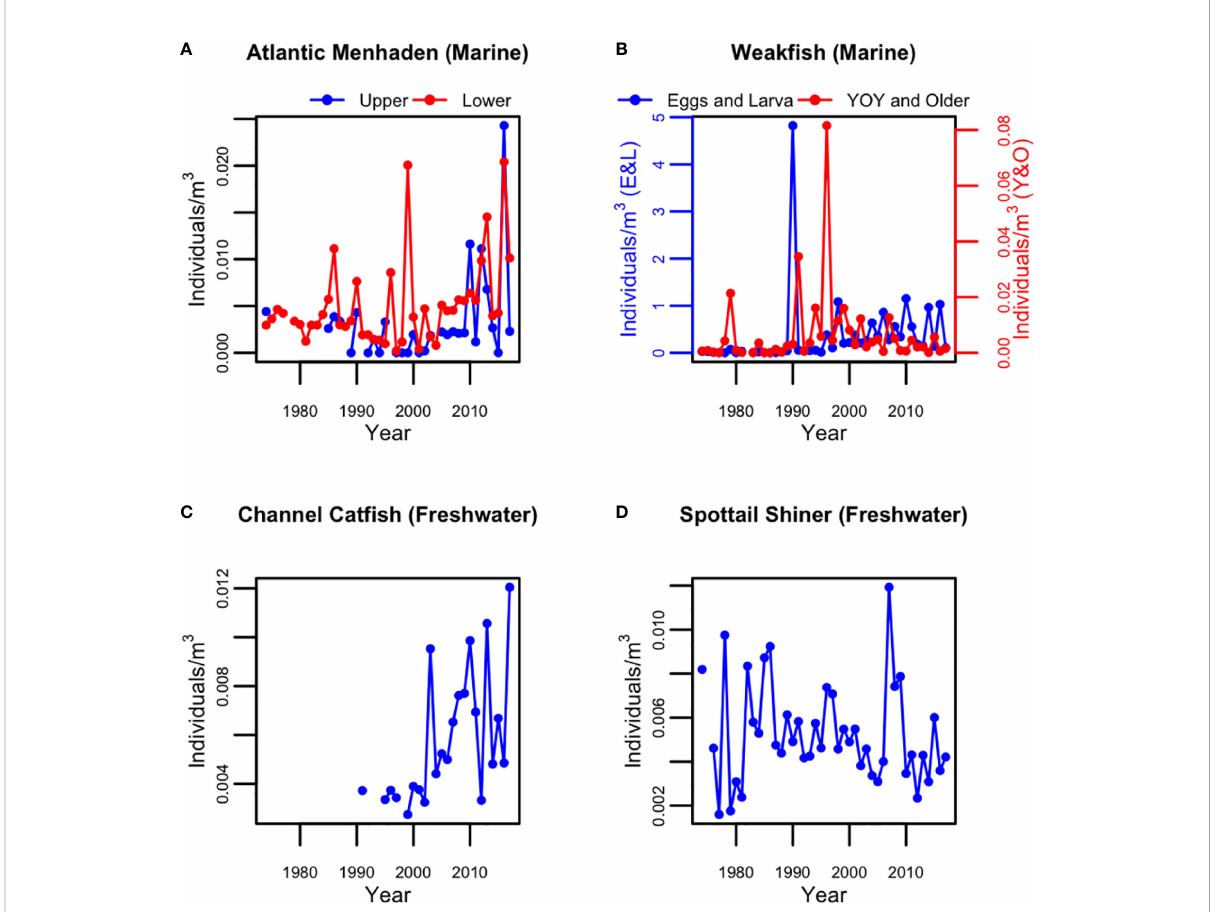
FIGURE 9 Abundance index for (A) Atlantic menhaden young-of-year (YOY) and older group in the upper and lower Hudson, (B) weak fi sh of the groups of Eggs and Larva and YOY and Older in the lower Hudson, (C) channel cat fi sh YOY and older group in the upper Hudson, and (D) spottail shiner YOY and older in the upper Hudson during May-July from 197 to